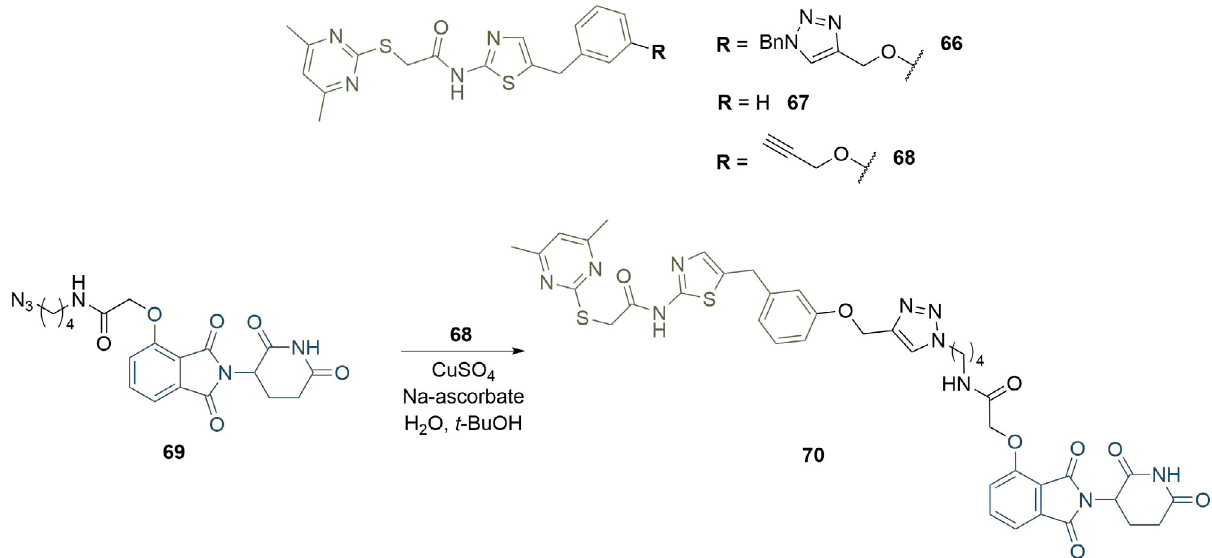
Figure 12. Use of triazoles to exploit intermolecular interactions. The nitrogen atoms in the triazole formed hydrogen bonds with R97 in Sirt2 in the crystal structure of 65. Following the click reaction with azide 69, triazole-containing PROTAC 70 retained these interactions in docking analysis of the